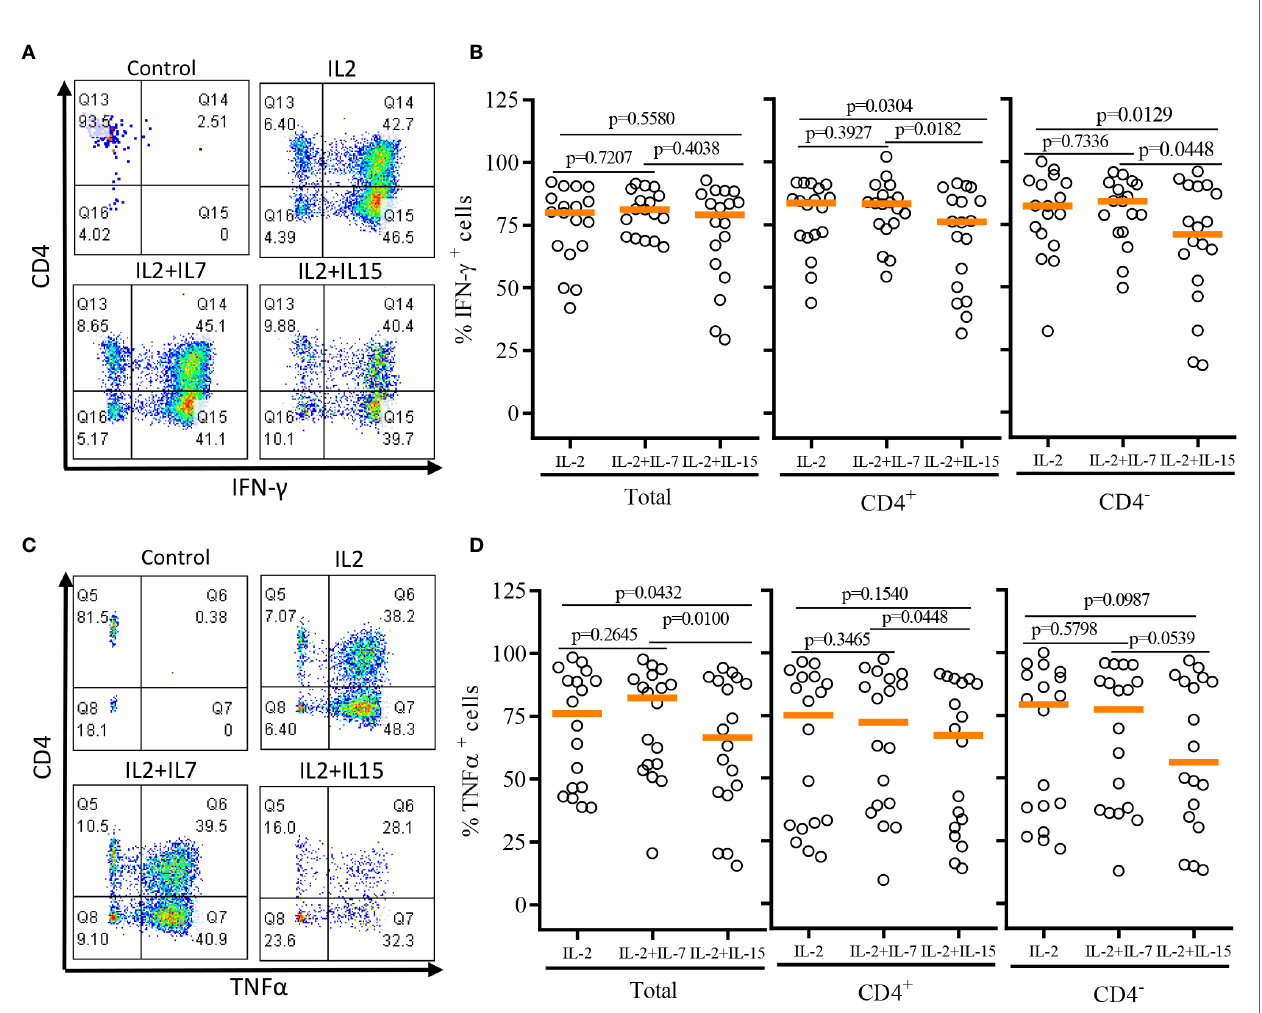
FIGURE 5 | Th-1 type cytokine production pro fi le of expanded human iNKT cells. The expanded iNKT cells were stimulated with PMA and Ionomycin and intracellular cytokine production pro fi les were assessed through multi-color fl ow cytometry. (A) Representative fl ow cytometric analysis of CD4 and IFN g of iNKT cells in post-expansion. (B) Percent IFN g + total, CD4 + , and CD4 - iNKT cells in post-expansion with IL-2, IL-2+IL-7, and IL-2+IL-15. (C) Representative fl ow cytometric analysis of CD4 and TNF a of iNKT cells in post-expansion. (D) Percent TNF a + total, CD4 + , and CD4 - iNKT cells in post-expansion with IL-2, IL-2+IL-7, and IL-2+IL- 15. Horizontal lines represent median values; p values are shown above each group. Each symbol represents a value from a single